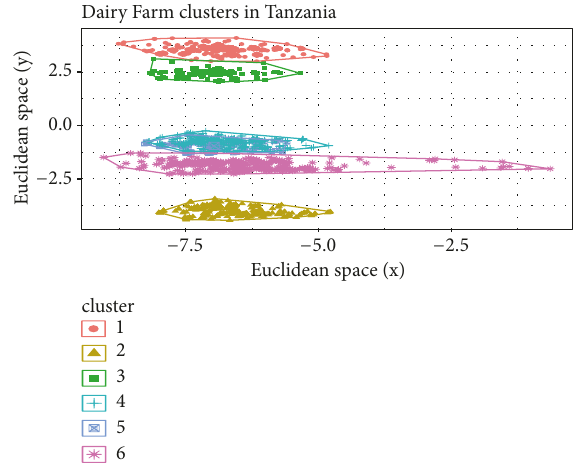
Figure 6: Household allocation into six clusters using the K-means model for Tanzania dairy